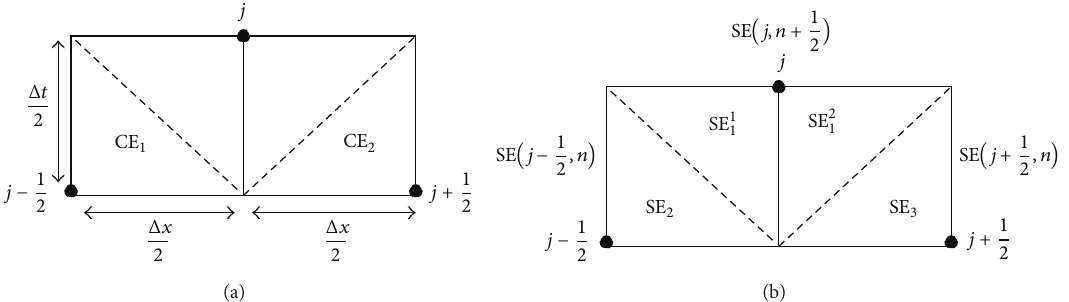
Figure 3: In both graphics (a) and (b) different subdivisions of the conservation element, CE (𝑗, 𝑛 + 1/2) , are shown. In (a) the two regions CEs that the CE (𝑗, 𝑛 + 1/2) is divided into are shown whereas in (b) the four SEs regions are shown.